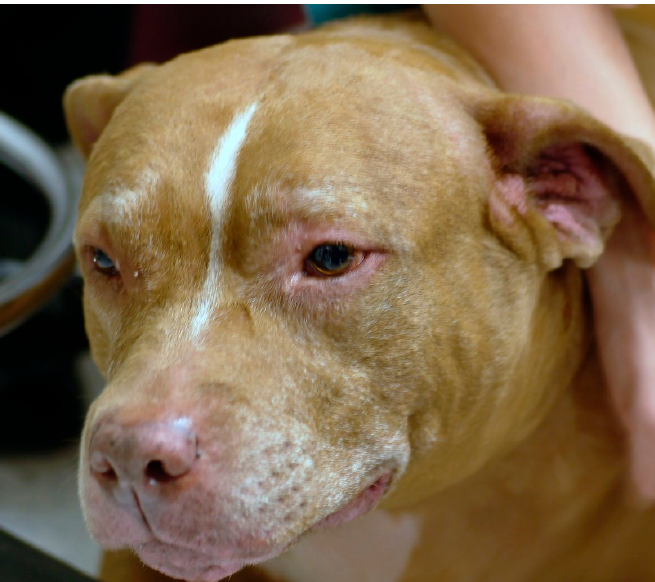
Figure 1. The muzzle, periocular area, and ears are predilected sites for atopic dermatitis in dogs, as shown in this patient.